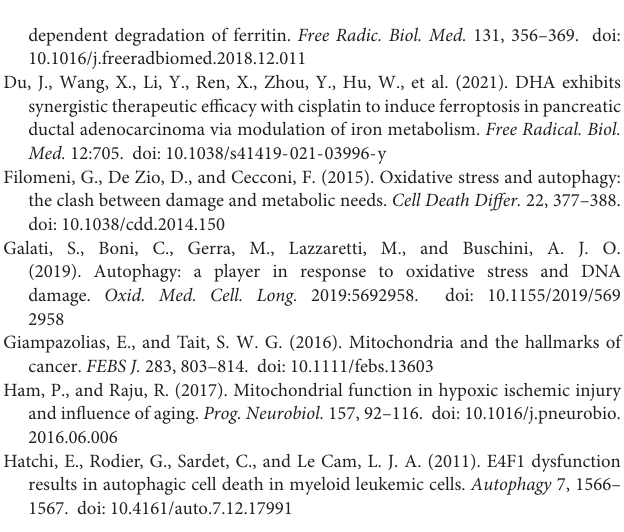
Supplementary Figure 1 | TEOA induced selective cytotoxicity of human pancreatic cancer cells. (A) Human normal pancreatic cells HPDE6-C7 cells, pancreatic cancer cells SW1990 and PANC1 cells were treated with various concentrations of TEOA (0–60 µ M) for 24 h. The cell viability was detected using CCK8 assays. (B) HPDE6-C7 cells and SW1990 cells were treated with various concentrations of TEOA (0–50 µ M) for 12 h. The cell viability and cytotoxicity were detected using Calcein/PI cell viability/cytotoxicity assay ( (cid:70)(cid:70) p < 0.01). Supplementary Figure 2 | Transwell assay of HPDE6-C7 cells treated with 0–25 µ M TEOA for 24 h. Supplementary Figure 3 | To assess intracellular ROS production, TEOA treated SW1990 and HPDE6-C7 cells were loaded with DCFH-DA, mitoSOX probe for 30 min followed by confocal laser microscope (Scale bars: 25 µ m). Supplementary Figure 4 | (A) SW1990 cells were treated with TEOA alone or in combination with 0.5 mM NAC, and then mitochondria membrane potential levels were measured by flow cytometry after 8 h. (B) Statistical analysis of relative mitochondria membrane potential level and the results were presented as mean ± SD from three independent experiments ( (cid:70)(cid:70) p < 0.01). Supplementary Figure 5 | Human normal pancreatic cells HPDE6-C7 cells, pancreatic cancer cells SW1990 and PANC1 cells were treated with TEOA at the indicated concentration of TEOA for 8 h and the ratio of LC3I and LC3II were detected by western blot. Supplementary Figure 6 | SW1990 cells were treated with/without TEOA (40 µ M) for 8 h, and autophagic vacuoles were observed using TEM. Scale bar: 2 µ m (left) or Scale bar: 0.5 µ m (right). Supplementary Figure 7 | After exposure to TEOA for 8 h, pancreatic cancer cells were collected to measure the level of p-AMPK and AMPK, GAPDH used as a loading control. Supplementary Figure 8 | Statistical analysis of Figure 8E and the results were presented as the mean ± SD from three independent experiments ( (cid:70)(cid:70) p < 0.01, (cid:70)(cid:70)(cid:70) p < 0.001). Supplementary Figure 9 | Indicated treated PANC1 cells were harvested and mTOR signaling pathway was determined by western blot. Supplementary Figure 10 | SW1990 cells were treated with TEOA alone or combined with CQ (25 µ M), Z-VAD-FMK (5 µ M), respectively, and CCK8 test was used to assess cell viability ( (cid:70) p < 0.05). Supplementary Figure 11 | SW1990 cells were treated with TEOA for 12 h, and the cell apoptosis was detected using Annexin V-FITC/PI apoptosis kit by flow